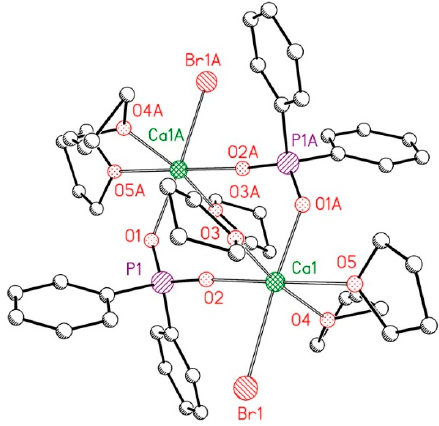
Figure 4. Structural motif and atom numbering scheme of [(thf) 3 Ca(Br)(µ-O 2 PPh 2 )] 2 ( 3a ). Symmetry related atoms are marked with the letter “A”. The ellipsoids represent a probability of 30%; the thf ligands are drawn with arbitrary radii. H atoms and disordering of the thf ligands are not shown. Bond lengths of the inner core (pm): Ca1–Br1 296.8(2), Ca1–O1A 225.5(6), Ca1–O2 221.6(5), Ca1–O3